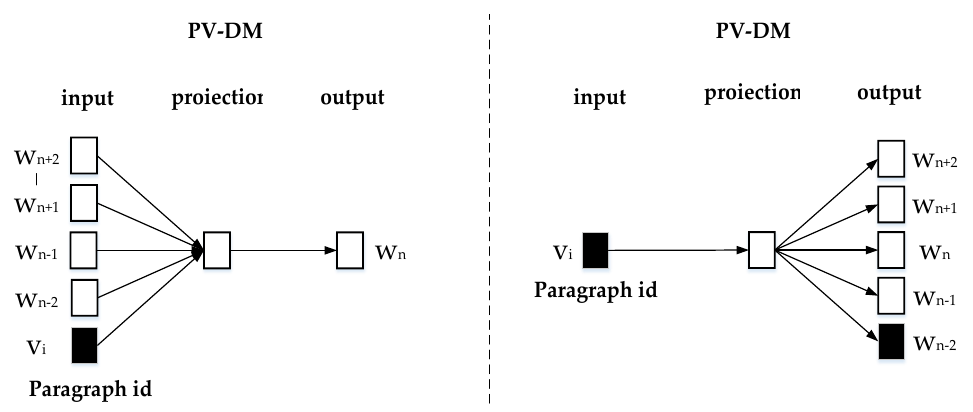
Figure 2. Two training methods of the Doc2Vec model.